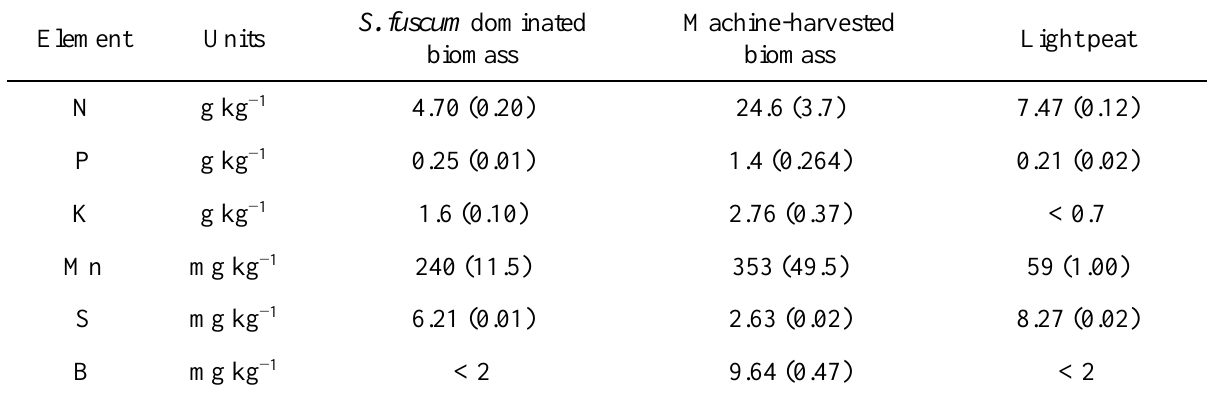
Table 2. Mineral nutrient contents in dry matter of Sphagnum biomass dominated by S. fuscum , machine- harvested Sphagnum and light Sphagnum peat. Standard deviation is given in brackets. For machine-harvested biomass, SFS-EN 15510:2008 was followed; in other cases the previous ISO 5516:1978 method was followed. n =